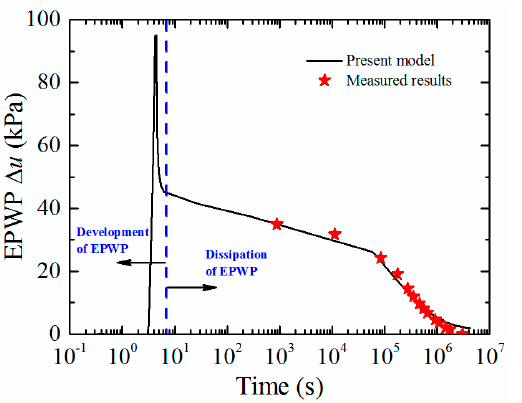
Figure 5. Development and dissipation of EPWPs around the jacked pile during and after pile in- stallation.